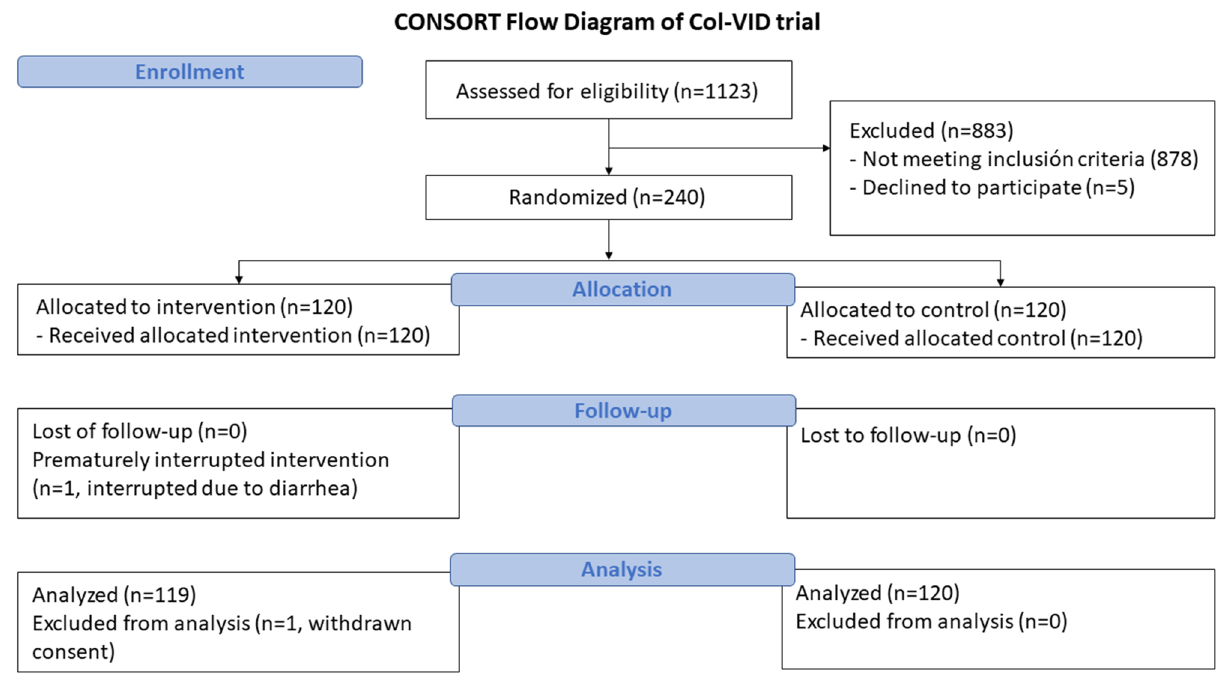
Figure 1. Consort flow diagram. The progress of all participants through the trial is